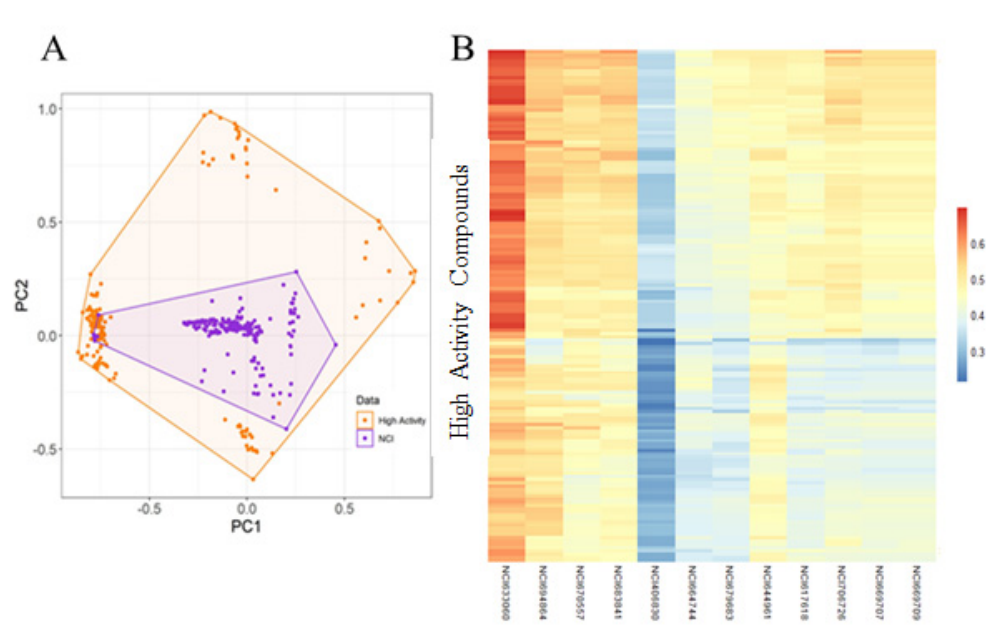
Figure 8. Library screening result. ( A ) Chemical space of selected active hits. ( B ) Heatmap showing the Tanimoto similarities score (Tc) of selected compounds with high activity compounds from training set. MACCS fingerprints were used to calculate the Tanimoto coefficient similarities.